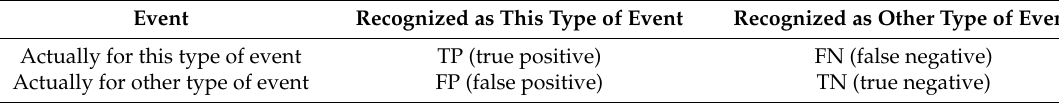
Table 6. Confusion matrix in event identification.